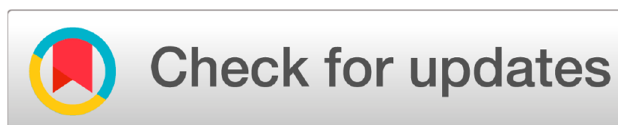
Figure 2. Crossmark icon serving alive publication in Crossref.